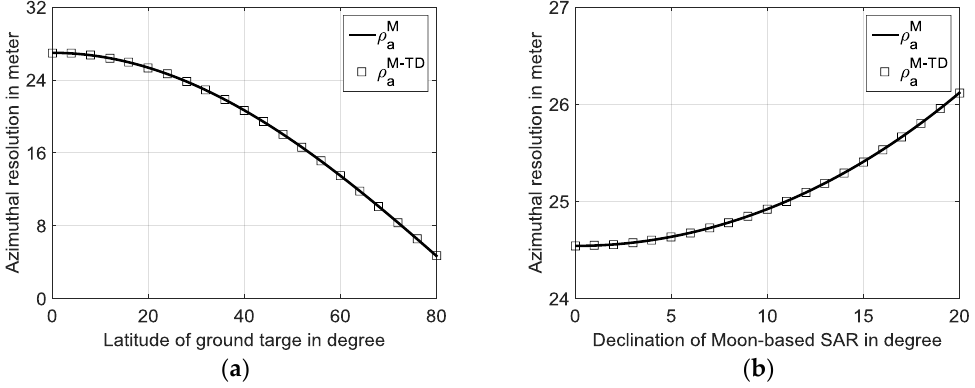
Figure 11. Dependence of azimuthal resolution on ( a ) ground target latitude; ( b ) declination of the lunar-based SAR. Superscript M denotes motional Moon-Based SAR, and the additional superscript TD indicates the propagation time delay.